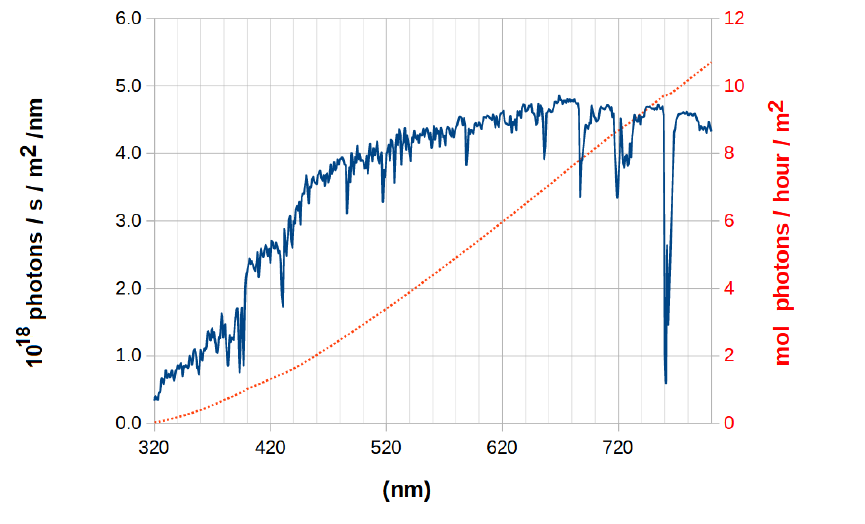
Figure 2 Surface solar spectrum (blue, continuous line) and its integration, the number of photons with energy above that of a given wavelength (red, dotted line, right axis). Data computed from the ref- erence spectrum ASTM G-173-03 ( International Standard Organization, 1992 ). Full-size DOI: